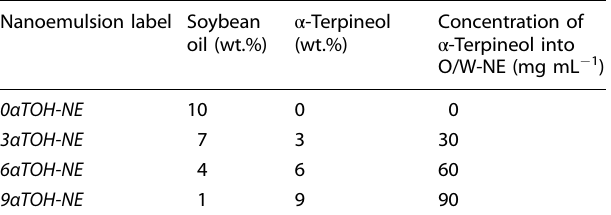
Table 4. The composition of the 10-wt.% of the oil phase O/W-NE using different ratios of α -terpineol: soybean oil. α -Terpineol Nanoemulsion label Soybean Concentration of α -Terpineol oil (wt.%) (wt.%)